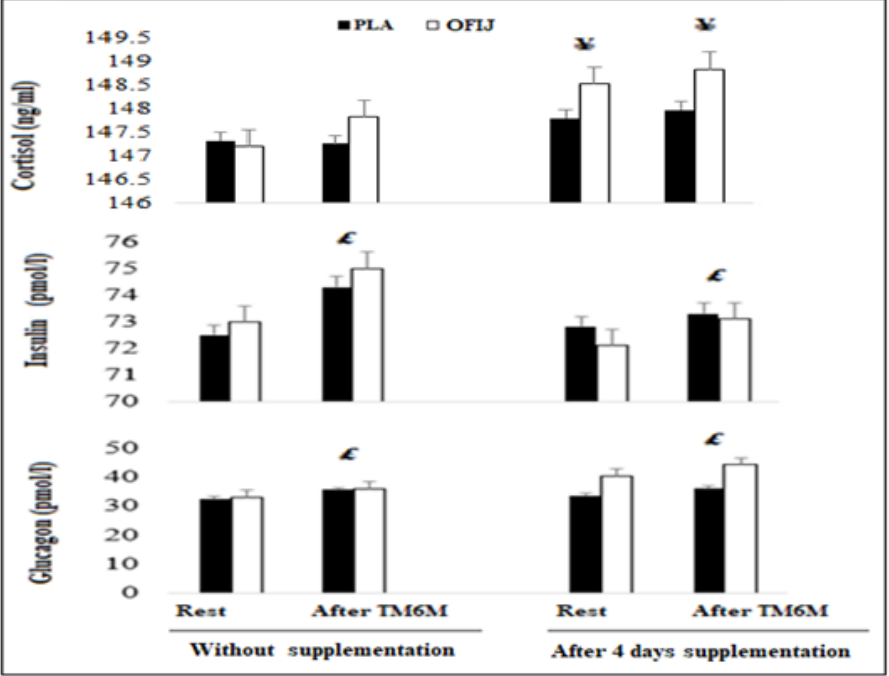
Figure 5. Hormonal parameters (mean ± SD; n = 20) recorded before and after the 6MWT during without and with supplementation of PLA and OFIJ. £: significant difference compared to before the 6MWT ( p < 0.05). ¥: significant difference compared to without supplementation ( p <